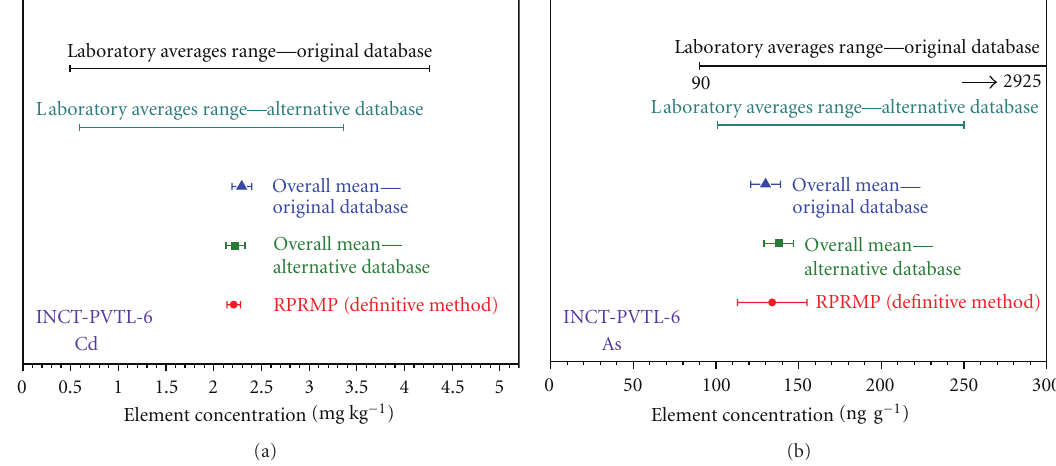
Figure 6: Comparison of the overall means and their confidence intervals for Cd and As in INCT-PVTL-6 obtained from the original and alterative databases with the result obtained by the definitive method and the ranges of laboratory